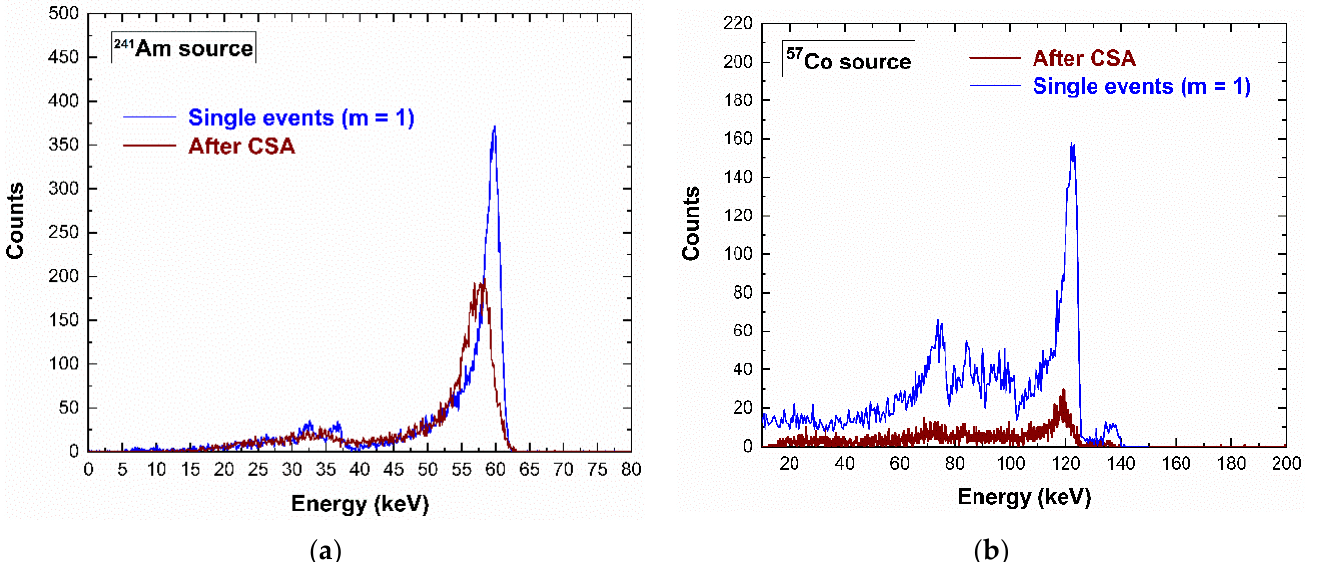
Figure 12. Measured ( a ) 241 Am and ( b ) 57 Co energy spectra after the application of the charge sharing addition (CSA) technique. The energy spectra of the single events (blue lines) and the spectra of the coincidence events with the two adjacent pixels (multiplicity m = 2) after CSA (brown lines). The energy spectra after CSA are characterized by energy deficits (2 keV at 59.5 keV and 3 keV at 122.1 keV), due to the presence of charge losses near the inter-pixel gaps. The curvature of the scatter plot, related to the 122 keV photopeak, highlights that the summed energy changes with the interaction depth (represented by the energy of the cathode). In particular, an energy deficit of about 2 keV at 122 keV was present even for photon interactions near the cathode, i.e., characterized by a full cathode energy of 122 keV. Because photon interactions near the cathode gave pulses with a small hole contribute, the hole trapping cannot justify the charge losses. This confirms that the presence of the energy deficit could be only due to distortions of the electric field lines near the inter-pixel